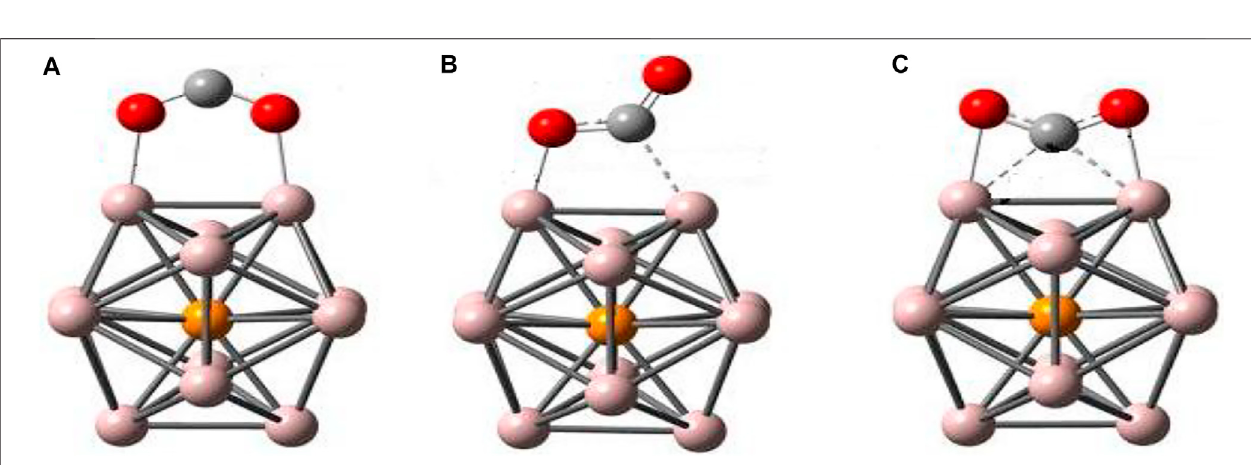
FIGURE 7 | Equilibrium structures of CO 2 complex with Al 12 P from Ref. 43 with the permission of Wiley.